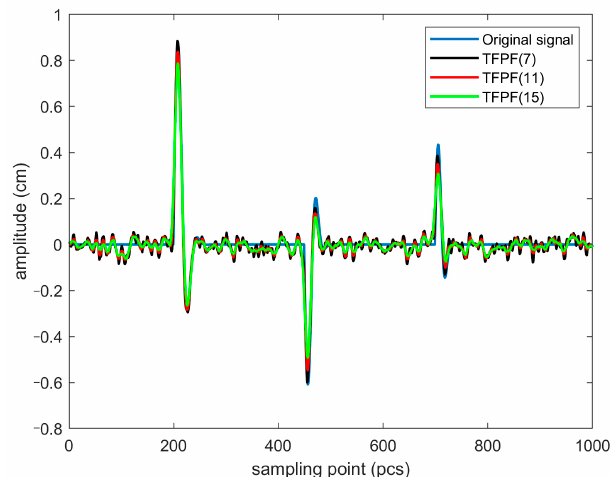
Figure 1. Original signal and denoising results with different window lengths.